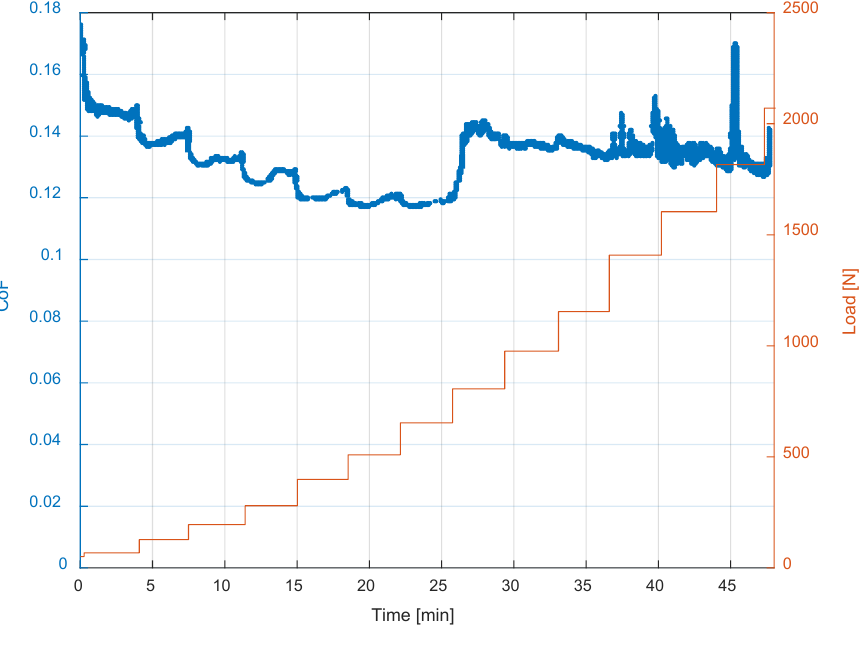
Figure 8. Case 4: Figure 8. Case 4: example. Figure 8. Case 4: example.